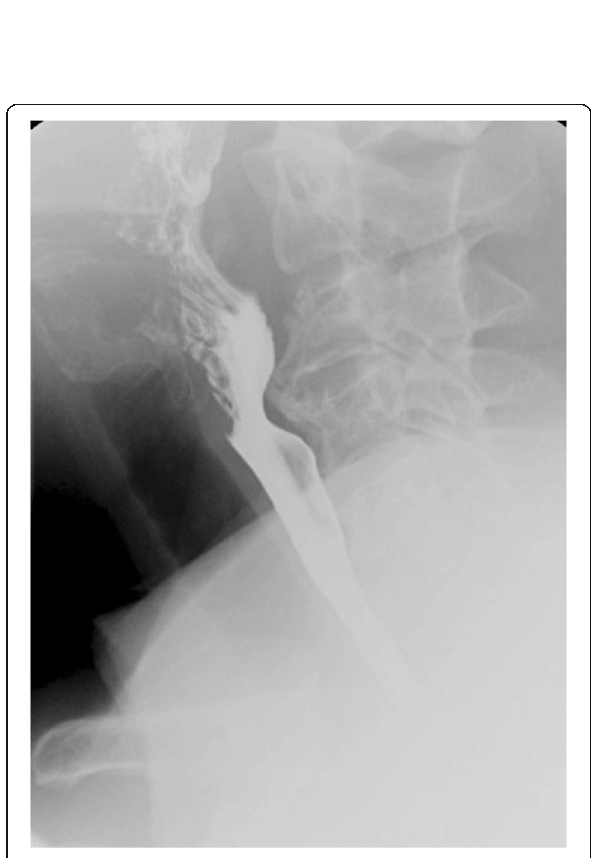
Fig. 16 Cervical osteophytes. Lateral fluoroscopic view of the cervical spine during an esophagram demonstrating large anterior cervical osteophytes of the C3/4 level causing posterior impression on the esophagus during swallowing